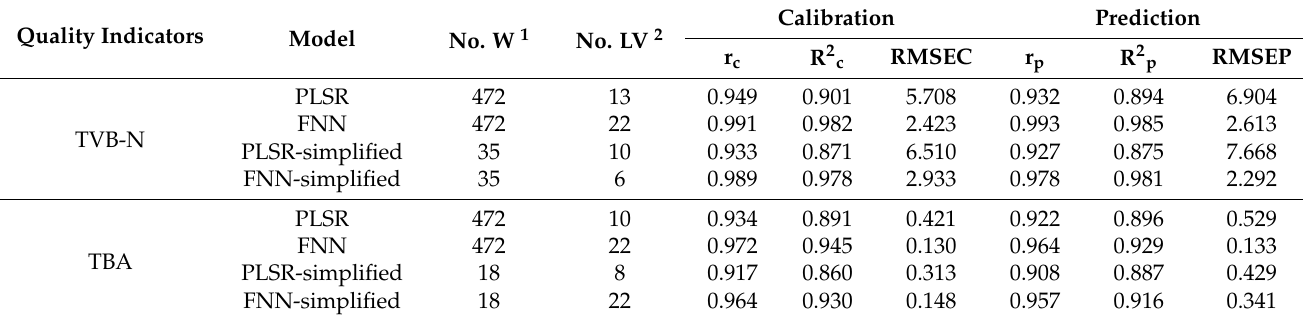
Table 2. Calibration and prediction results of TVB-N and TBA values for large yellow croaker fillet by HSI technology. Quality